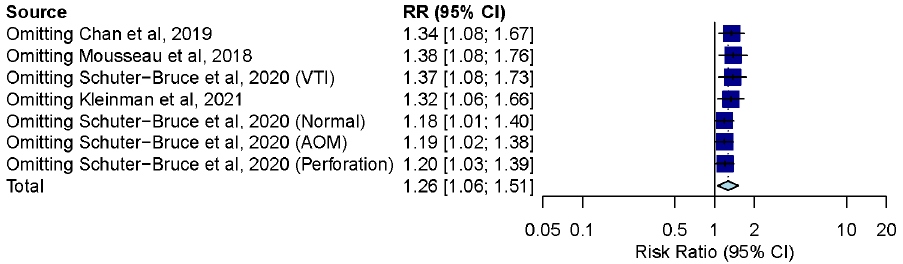
Figure 7. Influence analysis of the overall result of comparison between smartphone-enabled otoscopy and traditional otoscopy.